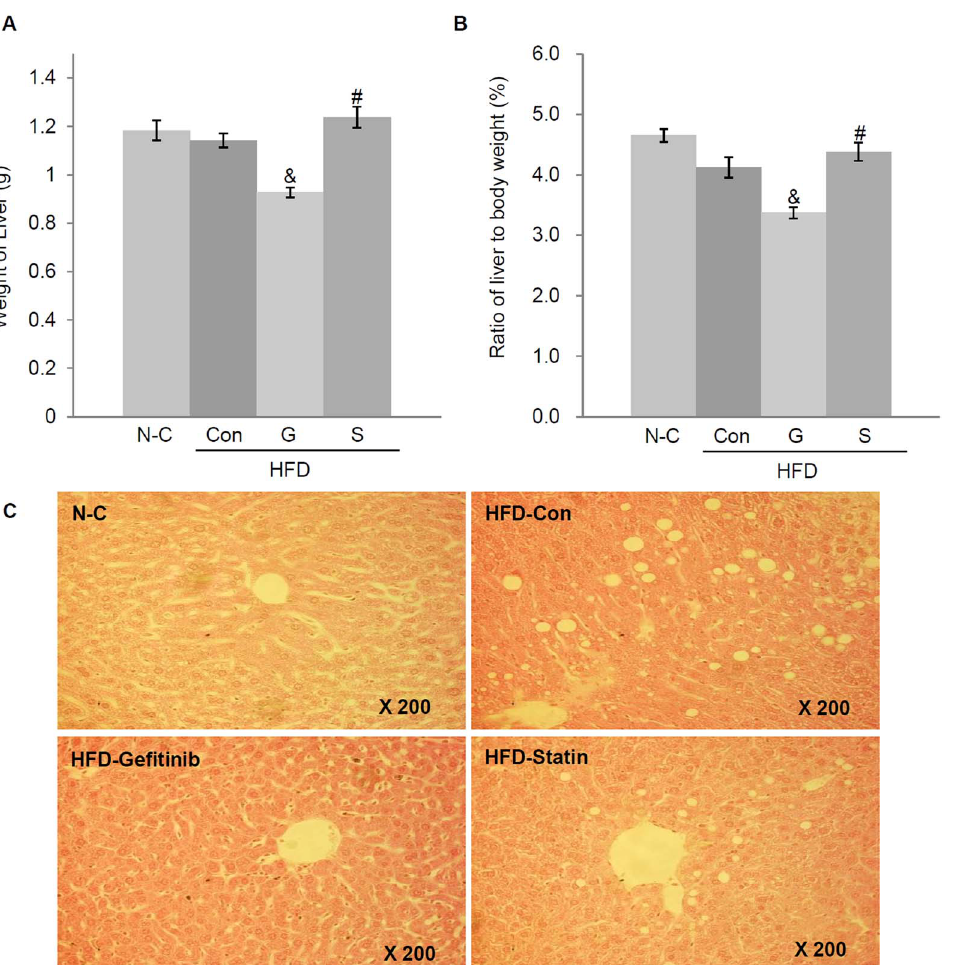
Fig. 3. Effects of gefitinib and statin treatments on liver pathology. Changes in the weight and pathology of the liver after 6 weeks of gefitinib or statin treatment. (A) Weight of the liver. (B) Weight of the liver after body weight adjustment. (C) Hematoxylin-eosin staining. All photomicrographs are 6 200 magnification. Values represent the means ¡ SEM. & P , 0.05 relative to Con, # P , 0.05 relative to G. N-C, normal control; HFD, high-fat diet; Con, control; G, gefitinib; S, statin.